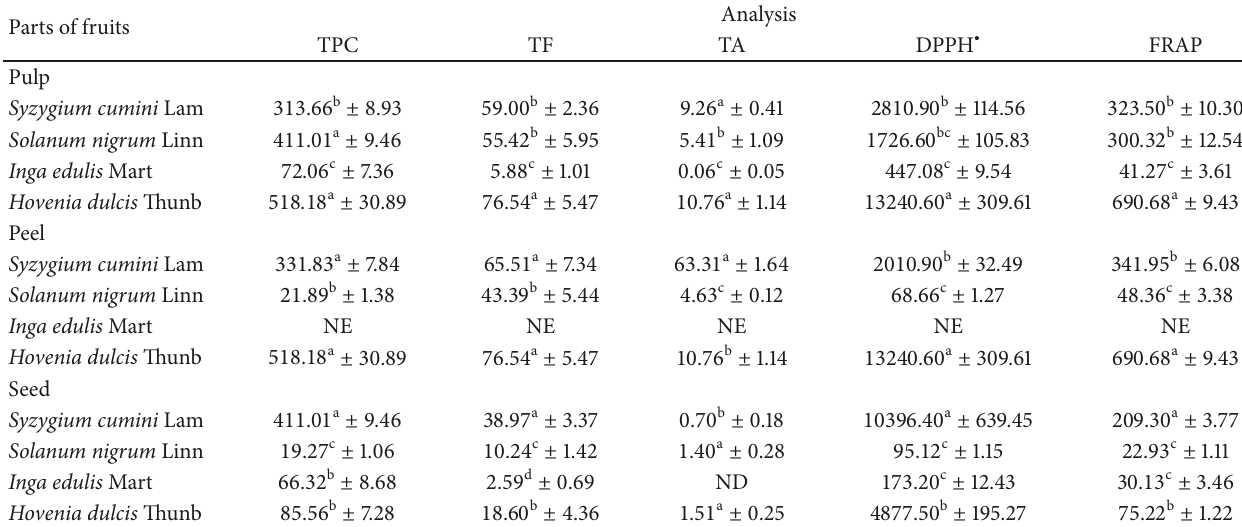
Table 2: Total phenolic content (TPC, mg GAE/100 g), total flavonoids (TF, mg/EQ g), total anthocyanins (TA, mg/100g), and antioxidant capacity by DPPH ∙ ( 𝜇 mol/TE g) and FRAP ( 𝜇 mol/Fe 2+ g) in different parts of fruits based on fresh weight (FW).